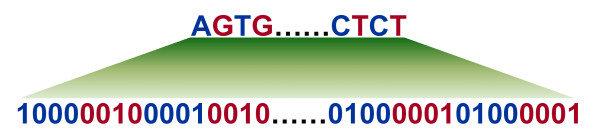
Illustration of embedding a short sequence in vector space. Each nucleotide in the sequence is converted to 4 indicator variables.